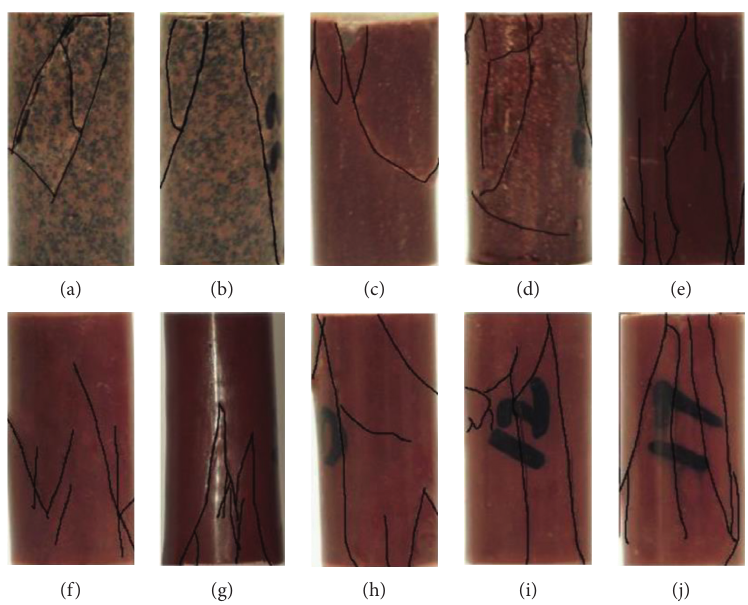
Figure 6: Temperature effect on the failure morphology of sandstone under triaxial compression [115]. (a) Fine sandstone at 25 ° C. (b) Fine sandstone at 160 ° C. (c) Medium sandstone at 25 ° C. (d) Medium sandstone at 160 ° C. (e) Argillaceous fine sandstone at 25 ° C. (f) Argillaceous fine sandstone at 160 ° C. (g) Silty mudstone at 25 ° C. (h) Silty mudstone at 80 ° C. (i) Silty mudstone at 120 ° C. (j) Silty mudstone at 160 °